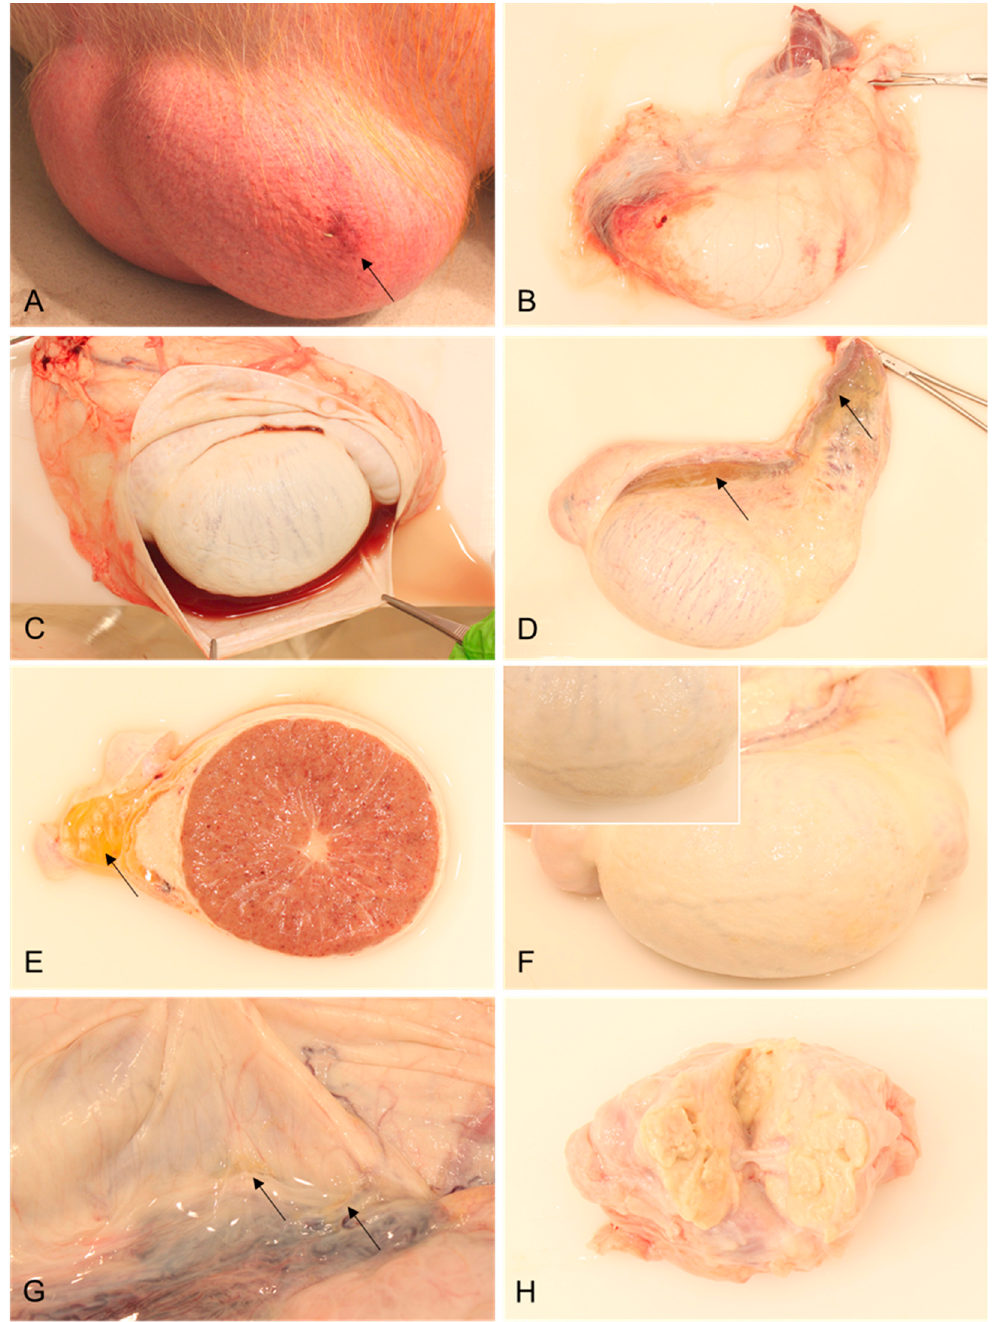
Figure 1. Representative lesions of reproductive organs in mature breeding boars infected with ASFV “Estonia2014”. ( A ) Scrotum with diffusely reddened skin, multifocal pinpoint hemorrhages, and a focal bruise (arrow); ( B ) testis in toto surrounded by hemorrhagic and edematous fascia spermatica externa; ( C ) opened processus vaginalis with a serosanguinous hydrocele; ( D ) testis in toto, with edematous proximal and distal mesorchia (arrows); ( E ) transversal section of the testis and epididymis with severe edema of the distal mesorchium (arrow) and multifocal hemorrhages in the testicular parenchyma; ( F ) testis in toto with mesothelial proliferations (inset: irregular tunical visceral surface with plaque-like lesions); ( G ) opened processus vaginalis with filamentous adhesions (arrow) of the parietal and visceral surface of the tunica vaginalis; and ( H ) cut surface of the prostate, with suppurative